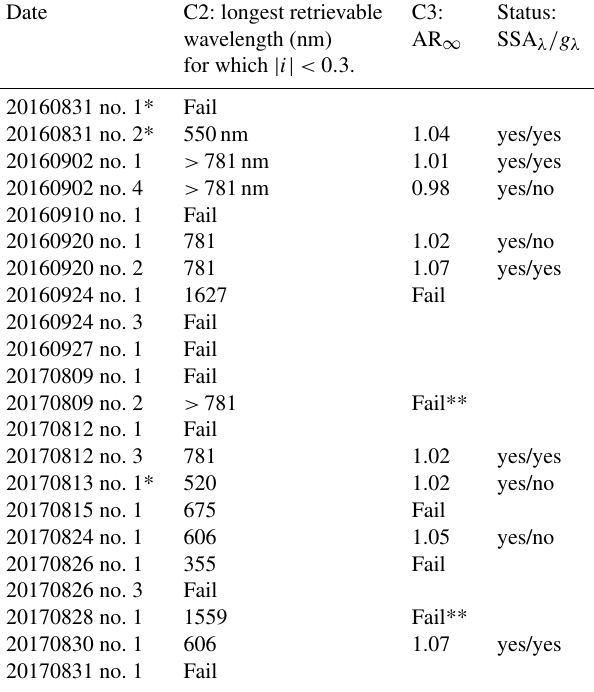
Table 1. Retrieval quality metrics. Spirals are listed by date and the number in which they were performed on a particular flight. Spiral cases that did not have data spanning the entire aerosol layer are ex- cluded from the chart (i.e., did not pass criterion no. 1). The second column lists the longest wavelength for which i λ remains below 0.3; the aerosol retrieval is only valid up to this wavelength. If i λ at all wavelengths is greater than 0.3, the case fails completely. The third column lists the AR ∞ value. The intercept must fall between 0.9 and 1.1 to pass this metric. The right-most column provides the sta- tus for the retrieval of SSA λ and g λ . Cases that are analyzed using the mean fit rather than the updated linear fit (update 2 from C19) are indicated by *. Cases that pass a metric but have a bad spectral shape in the albedo ratio (indicating failure) are indicated by